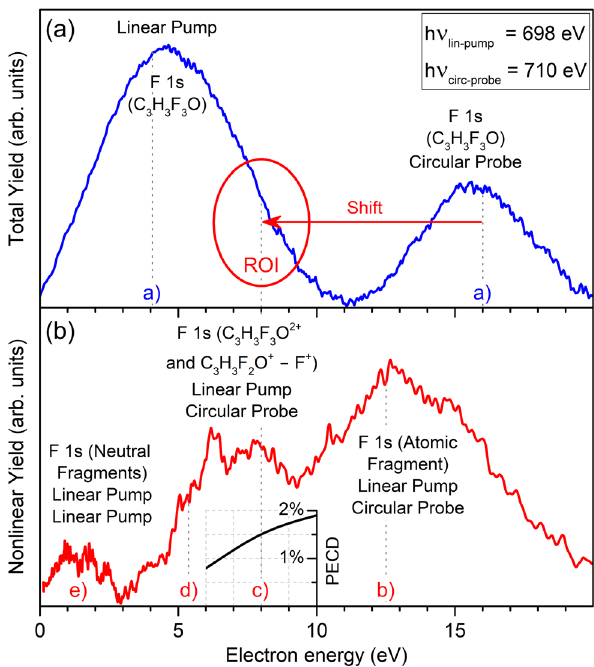
Fig. 5 Assignment of spectral contributions. Panel ( a ) illustration of energy distributions of the total and panel ( b ) nonlinear electron emission yields for the exemplary case of τ = 60 fs. The former is dominated by the one-photon absorption signals, while the latter by the two-photon absorption signals (as indicated in each panel). The calculated contributions of core electrons of fl uorine under different conditions are indicated by letters a) – e) and, for the subject of this study c), an arrow further illustrates the shift. Those linear and nonlinear contributions correspond to: a) one photon ionization of the neutral molecule with the pump or probe pulse, and b) – e) ionization of F 1s in different fragments, as indicated in the panel (see also text for details). An inset to the lower panel illustrates the theoretically predicted kinetic-energy-dependence of the total PECD, computed for the respective internuclear separation of Δ R = 4